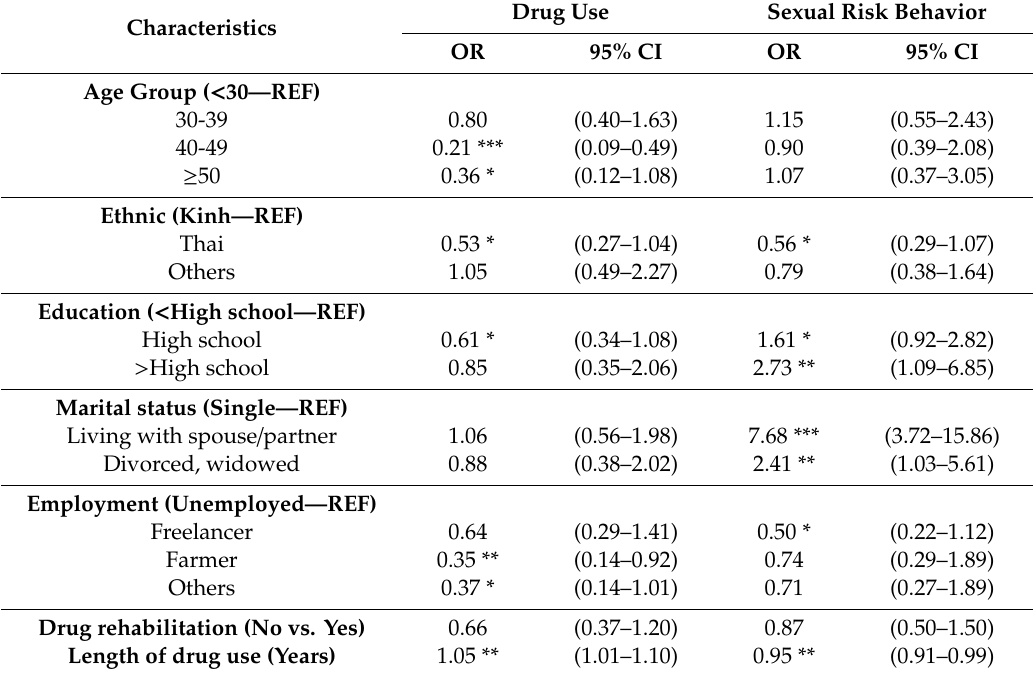
Table 5. Factors associated with substance abuse and sexual risk behavior among